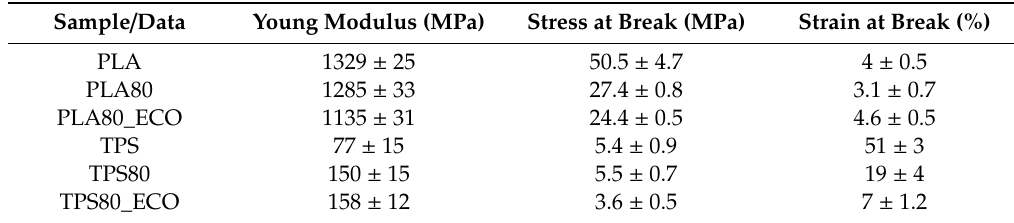
Table 3. Mechanical properties of PLA- and TPS-based